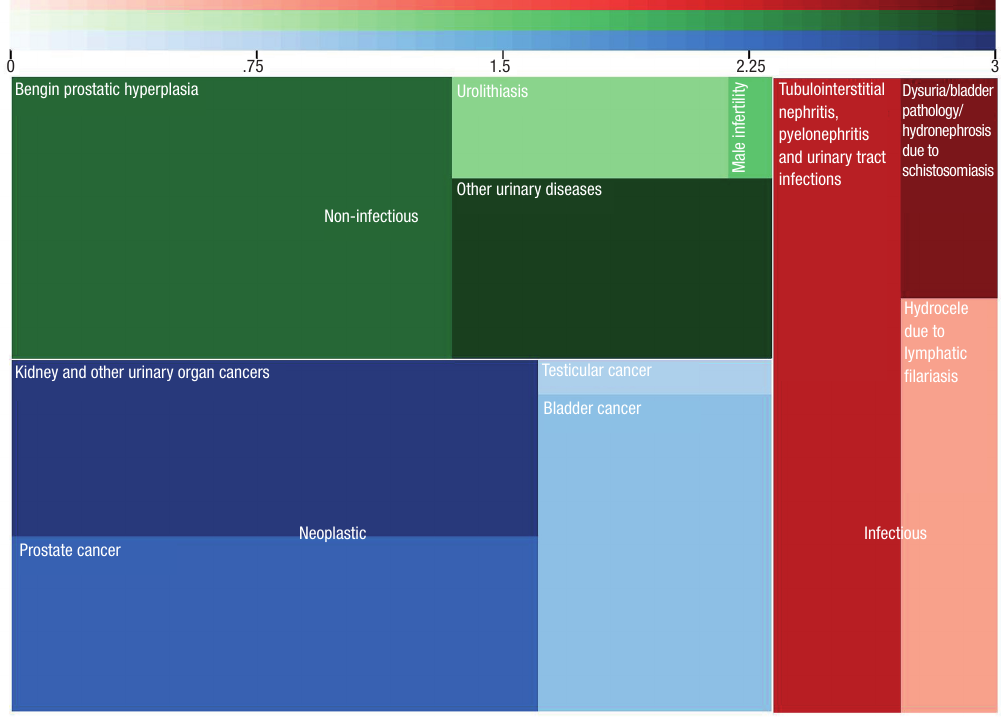
green = non-infectious conditions, red = infectious conditions, and blue = neoplastic